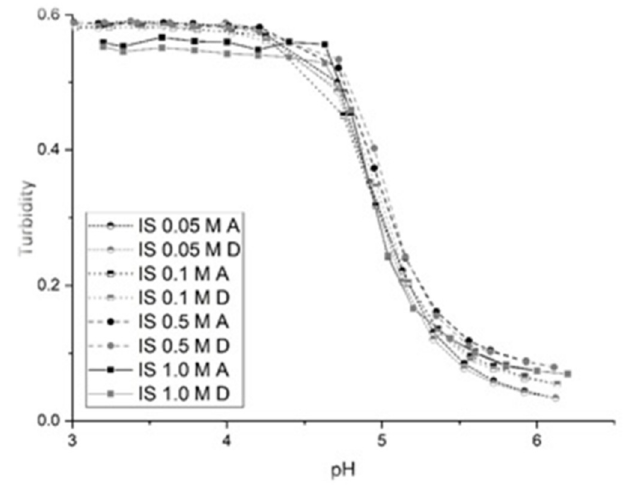
Figure 3. pH response profiles of NK 1-60 at the following ionic strengths: 0.05, 0.1, 0.5, and 1.0 M (black/A = ascending, gray/D = descending).